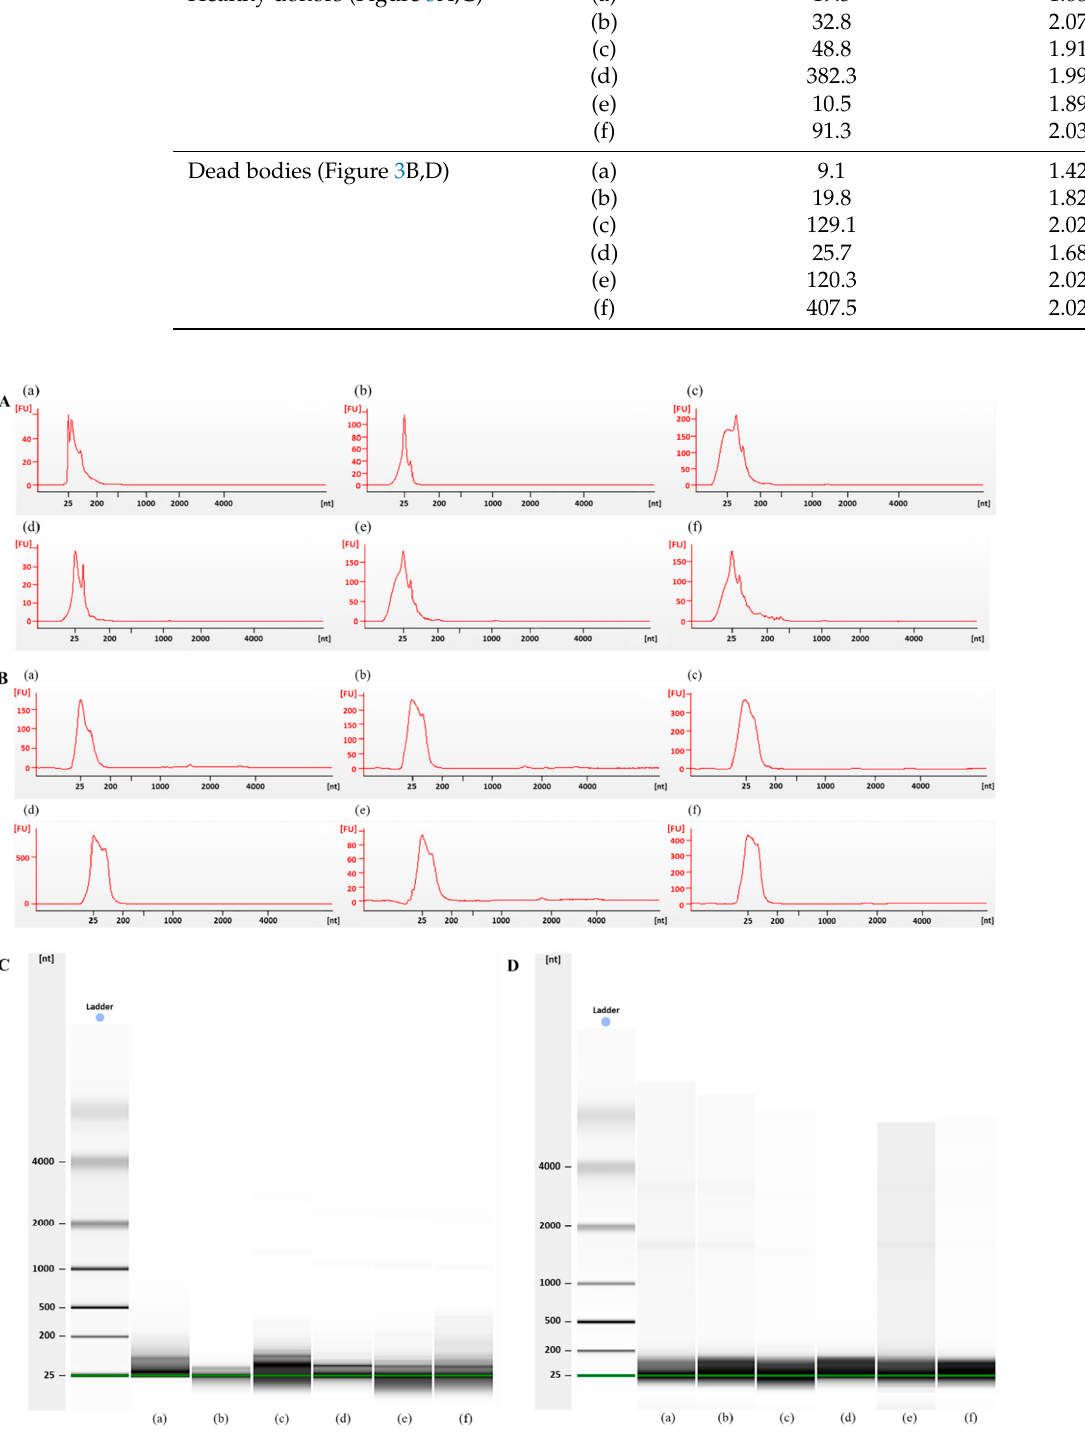
Figure 3. Evaluation of the exosomal RNA quality in the plasma of healthy donors and dead bodies. ( A ) Electrophoretic spectrums and ( C ) gel images of the exosomal RNA species derived from the plasma of healthy donors at 0 ( a , d ), 24 ( b , e ), and 48 ( c , f ) h after isolation. ( B ) Electrophoretic spectrums and ( D ) gel images of the exosomal RNA from the plasma of dead bodies from six different autopsy cases ( a – f ). FU, fluorescence units; nt, nucleotides.